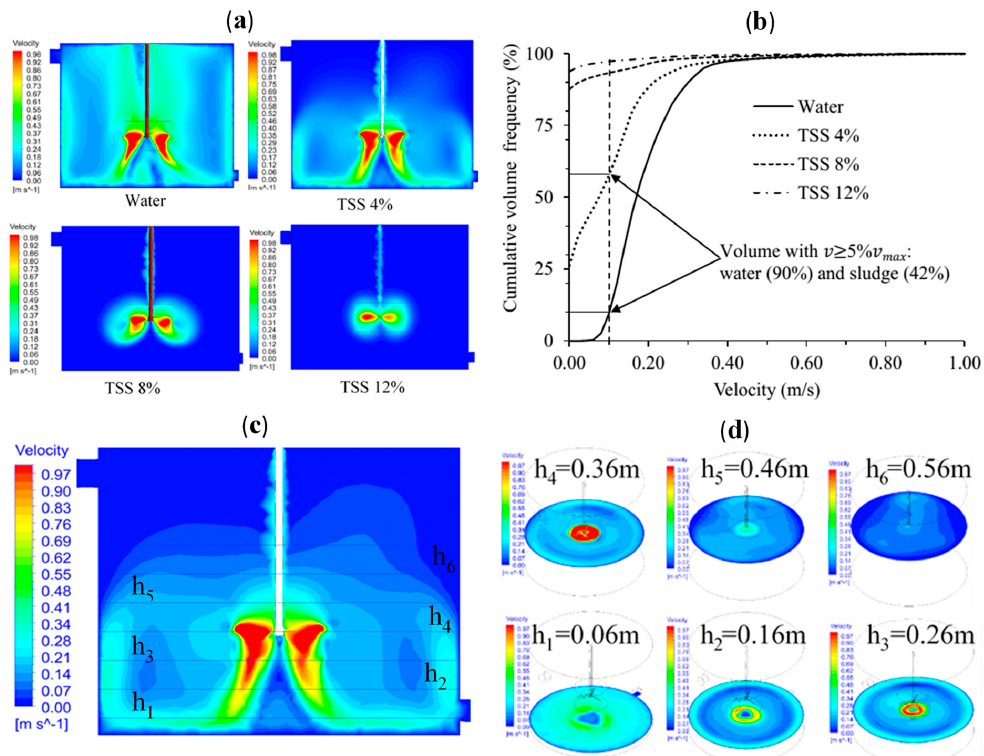
Figure 3. ( a ) Contour of velocity distribution in a vertical plane view; ( b ) cumulative volume frequency Figure 3. (a) Contour of velocity distribution in a vertical plane view (b) Cumulative volume frequency in 3-D (c) Contour plot of velocity for the sludge TSS 4% with different height in indication on horizontal in 3-D; ( c ) contour plot of velocity for the sludge total suspended solids (TSS) at 4% with di ff erent plane (d) Contour plot of velocity on the horizontal plane which indicated in (c). heights indicated on a horizontal plane; ( d ) contour plot of velocity on the horizontal plane which is indicated in ( c Figure 3 (c) indicates a velocity contour plot of the sludge with TSS 4% and sliced at different heights.